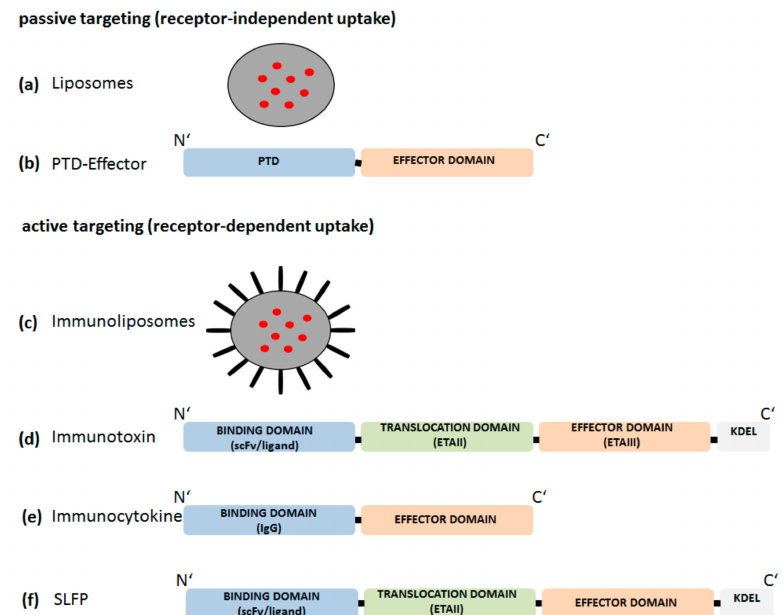
Figure 4. Tools for “passive” or “active” targeting. ( a ) non-specific uptake (passive targeting) of liposomes (grey circles) followed by intracellular release of encapsulated substances (red circles). ( b ) non-specific uptake of an e ff ector molecule coupled to a protein transduction domain (PTD). ( c ) specific uptake (active targeting) of immunoliposomes (IP). Whole antibodies, ligands, or single chain variable fragments (scFv) (black bars) are coupled to the surface of liposomes (grey circles). IP release their encapsulated substances (red circles) after receptor-mediated uptake. ( d ) Recombinant modular proteins consisting of a specific binding domain (ligand or scFv), a translocation domain (ETAII) and an e ff ector domain for cell killing (ETAIII). The KDEL motif is included for Golgi to endoplasmic reticulum (ER) transport. ( e ) Immunocytokines contain an IgG binding domain and an e ff ector domain. ( f ) Sneaking ligand fusion proteins (SLFPs) are recombinant modular proteins consisting of a specific binding domain (ligand or scFv), the ETAII translocation domain (ETAII) and an e ff ector domain for intracellular modulation of signaling